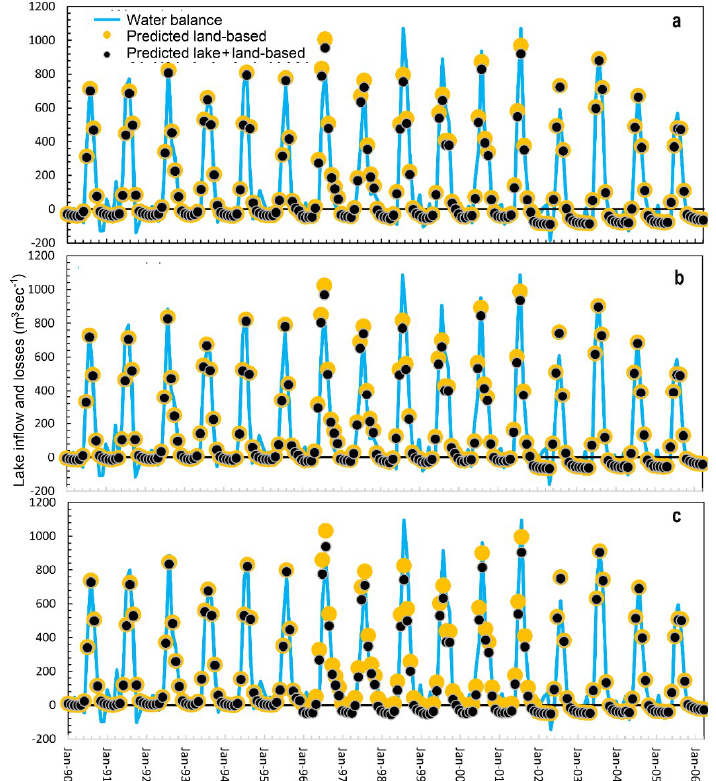
Figure 9. Inflows and water losses of Lake Tana and the surroundings determined with the water balance and predicted with the regression equation for land‐based and lake + land‐based for three evaporation rates ( a ) 1426 mm a − 1 ; ( b )1650 mm a − 1 ; and ( c )1789 mm a − 1